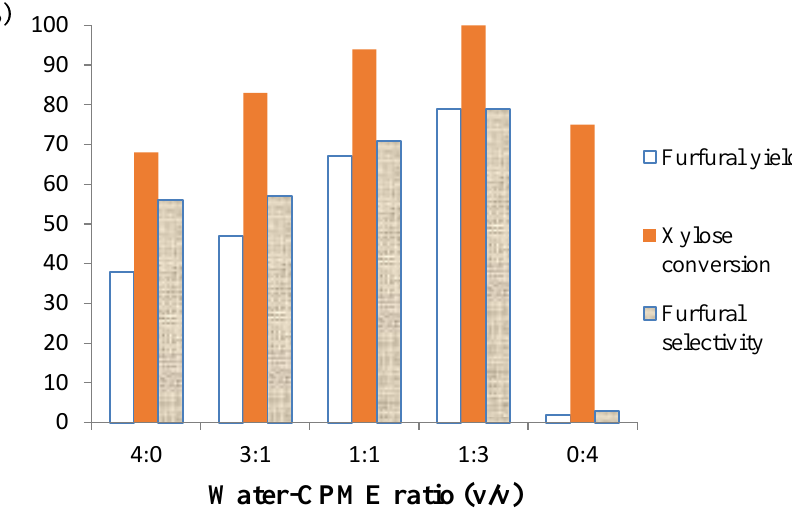
Figure 3. Effect of the water-CPME volumetric ratio on dehydration of D -xylose to furfural. Reaction conditions: Nafion NR50 (2 pellets), NaCl (95 mg), D -xylose (1.0 mmol), water-CPME, MW, 170 °C and 40 min.